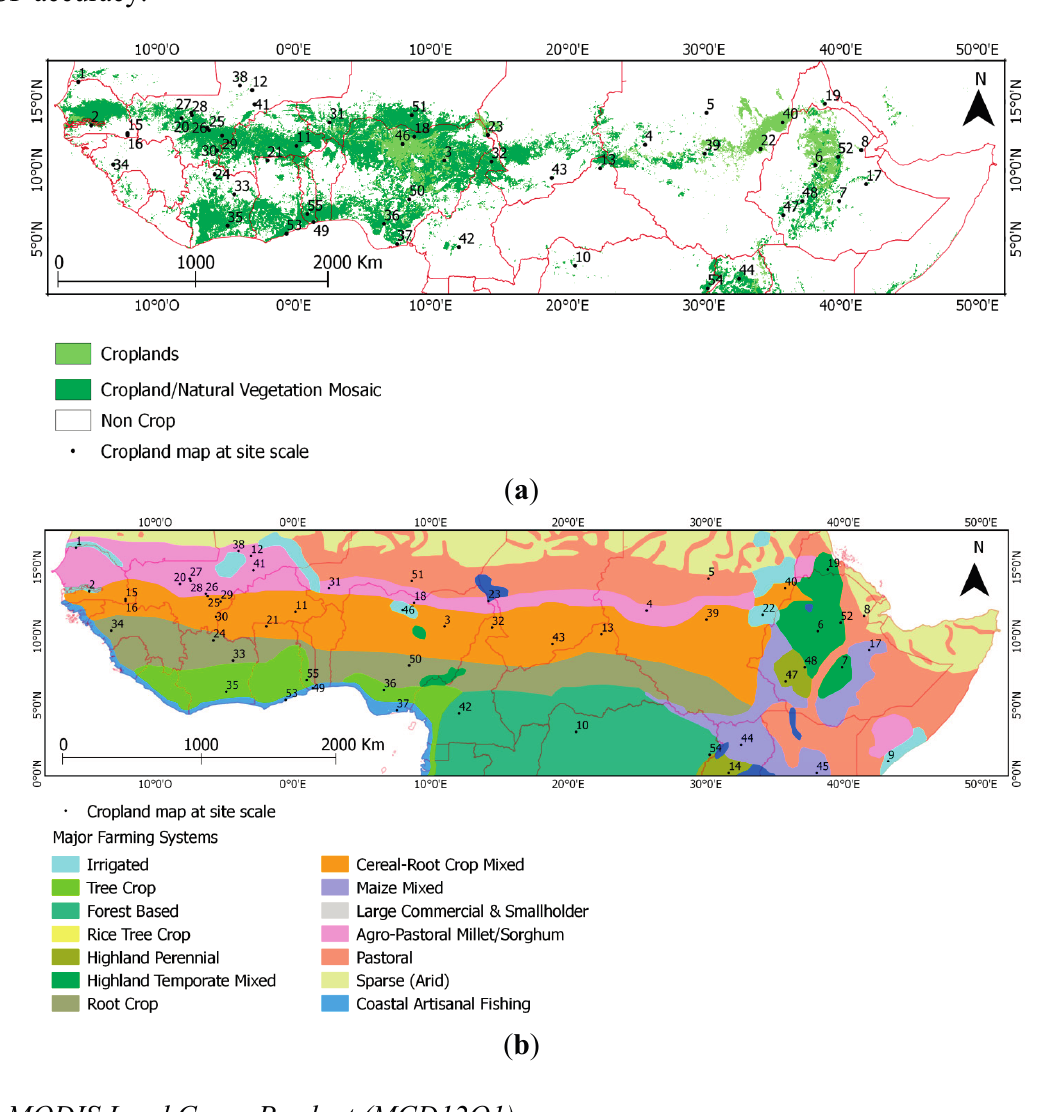
Figure 1. ( a ) Distribution of the averaged Croplands and the Cropland/Natural Vegetation Mosaic domains between 2001 and 2011; ( b ) Study area with the major farming systems, as defined in [36]. The points refer to the locations of the 55 cropland maps from high-resolution images, and they are used as reference data to assess the MODIS LCP